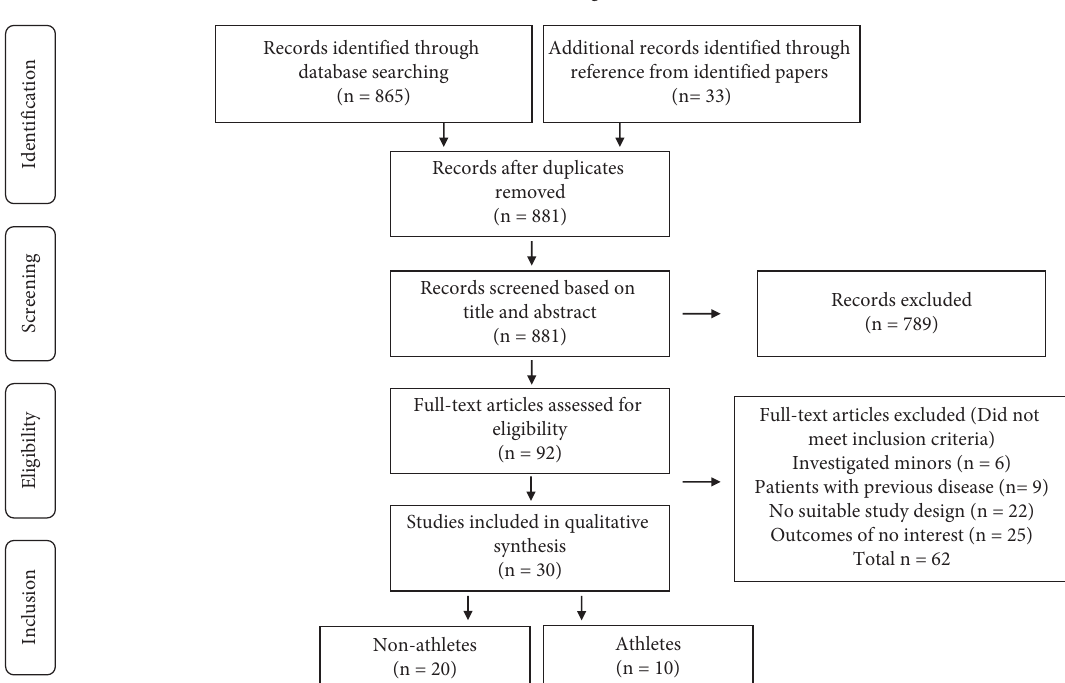
Figure 1: PRISMA fow diagram: this fgure shows the PRISMA fow diagram of identifed papers. Te citations yielded by the electronic search were screened by reviewing the title or abstract of each. 789 papers were excluded, and 92 publications were assessed for eligibility. From these, 62 did not suit the inclusion criteria and were excluded. Finally, 30 articles were included in the qualitative